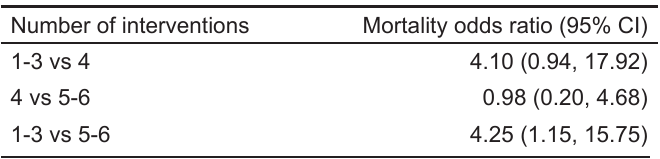
SOFA , sequential organ failure assessment; APACHE II , acute physiology and chronic health evaluation